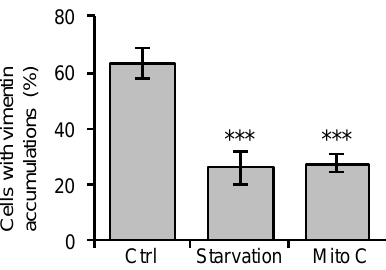
Figure 4. Serum starvation or mitomycin C treatment reduces the fraction of immature VIM SA/SA astrocytes containing vimentin accumulations. Immature astrocytes were cultured for three days in normal media (Ctrl), one day in normal media followed by two days in media without FBS (Starvation), or two days in normal media followed by 4 h exposure to mitomycin C (10 µg/m) then one day in normal media (Mito C). Cells were fixed and vimentin was visualized by immunofluorescence. On average, 460 cells were evaluated for each condition. N = 6 per group, *** p < 0.001.